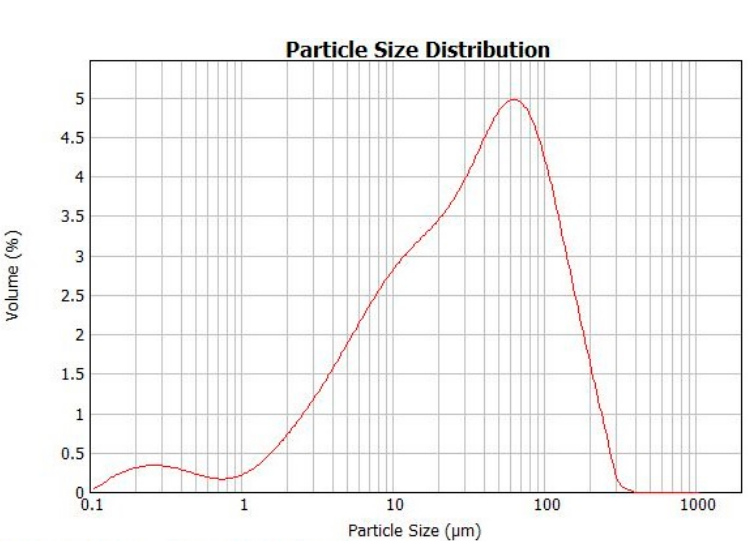
Figure 1. Particle size distribution related to the volume fraction of FBC FA determined using Malvern MasterSizer 2000.